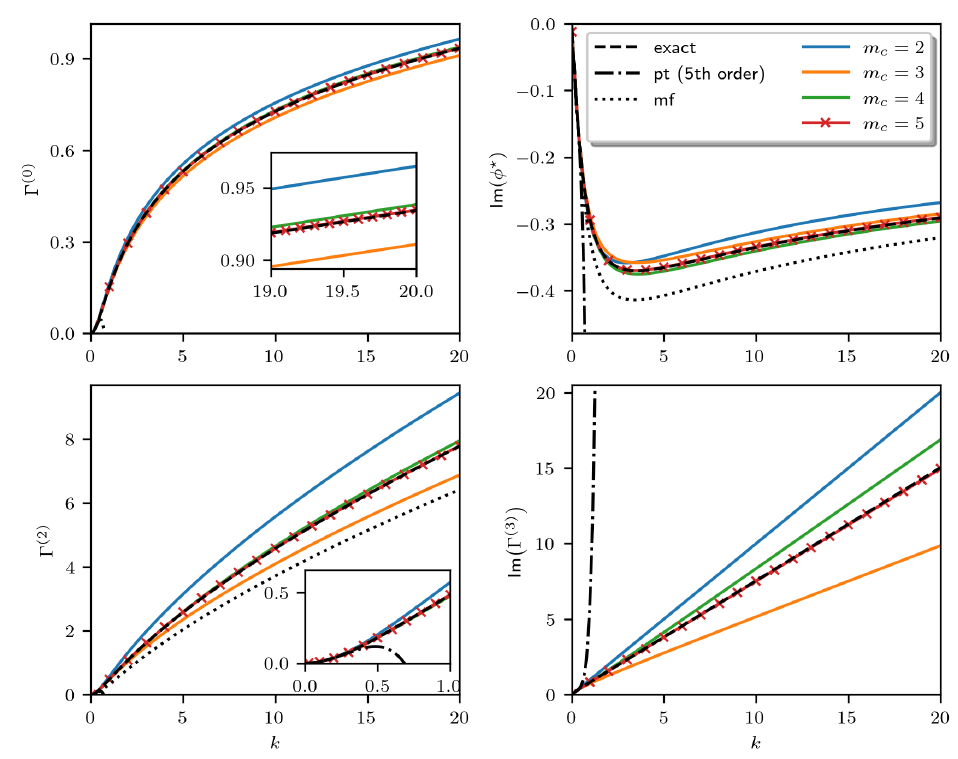
Figure 2: Results for classical integral. Exact solution (dashed line) obtained from an analytical calculation of the integral are compared with perturbation theory (pt, dash- dotted), mean-field theory (mf, dotted) and the FRG (full, color-coded) truncated at = m c